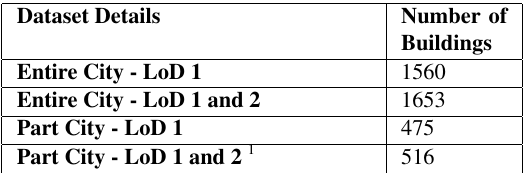
Table 1: Dataset Details -